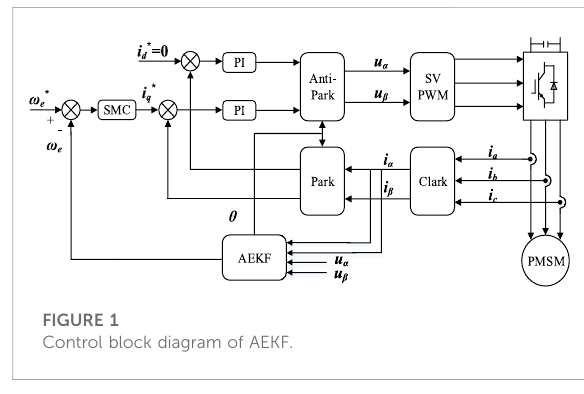
FIGURE 1 Control block diagram of AEKF.